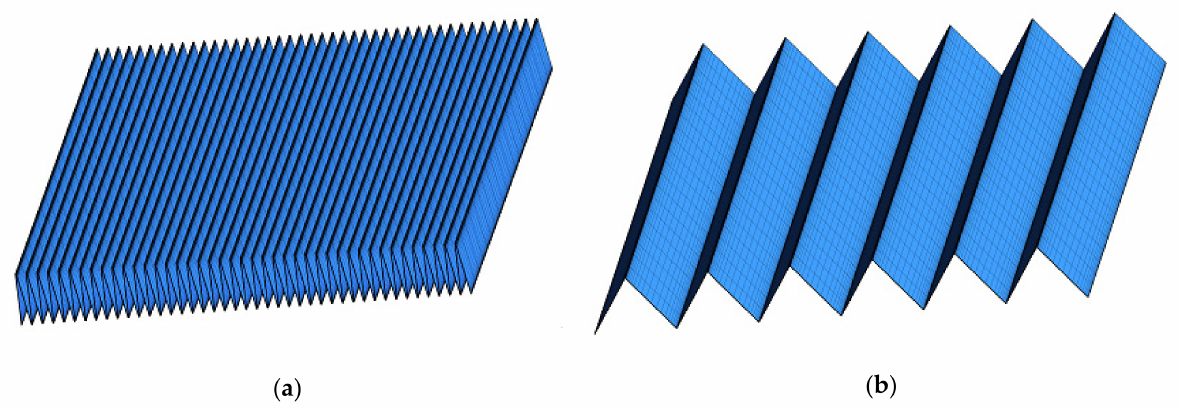
Figure 17. Examples of pleated filter geometry and mesh. ( a ) Height 10.5 mm, spacing 2.5 mm; ( b ) Height 10.5 mm, spacing 20